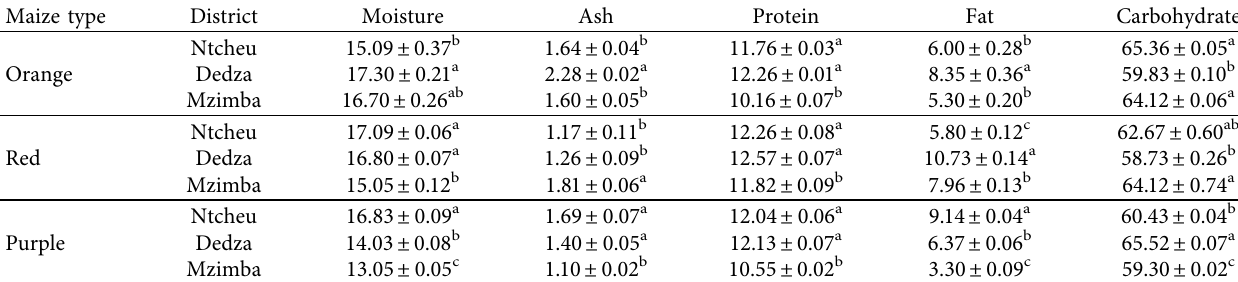
Table 1: Proximate content (percentage on a dry weight basis) of whole grain PLMVs. Maize type District Moisture Ash Protein Fat